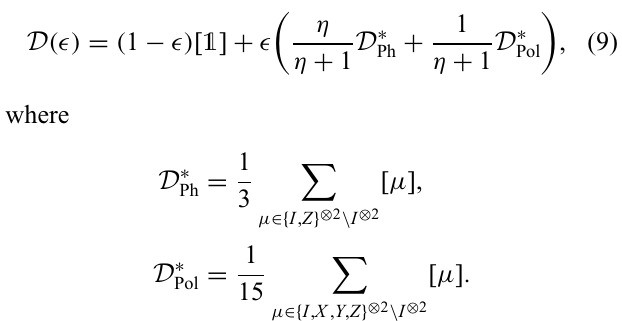
FIG. 4. Error model after each set of single-qubit gates (blue) and two-qubit gates (black). Unitary single-qubit gates U may be either single-qubit Clifford gates or arbitrary rotations around the y axis of the Bloch sphere. Here γ (orange) describes the amplitude damping channel, while D (red) describes a biased dephasing and depolarizing channel [the channel is described in the main text, Eq. (9)].